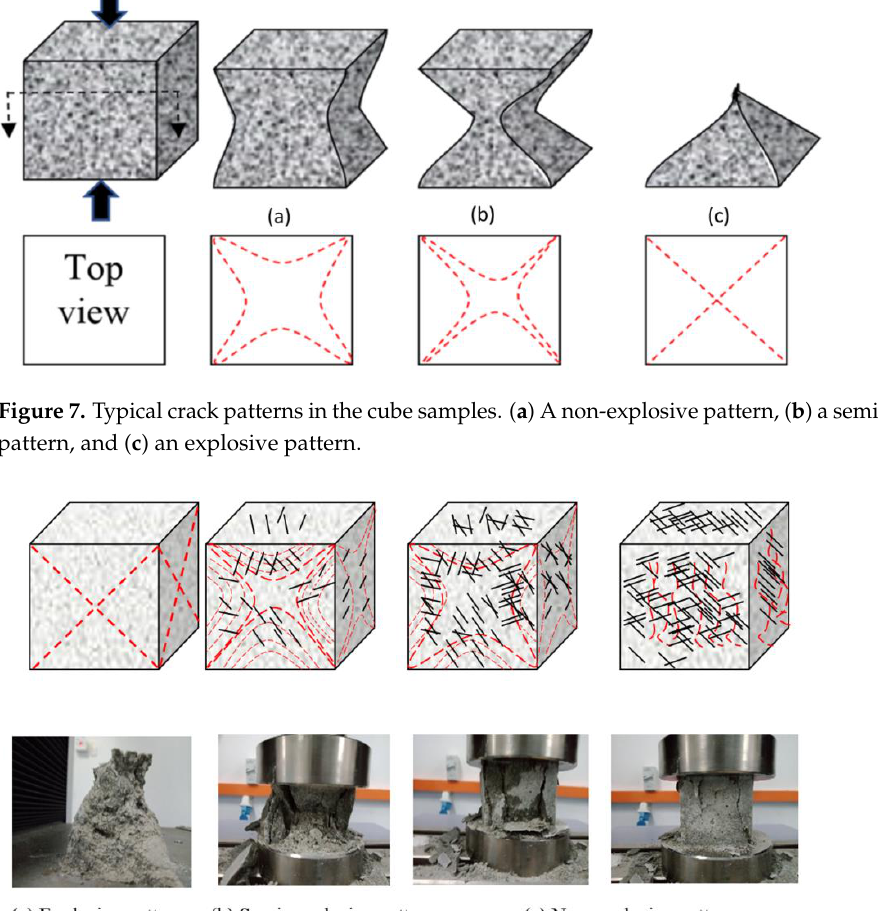
Figure 8. The efficiency of CSWFs with regard to the ability to bridge crack patterns. ( a ) Explosive pattern; ( b ) Semi-explosive pattern; ( c ) Non-explosive pattern.